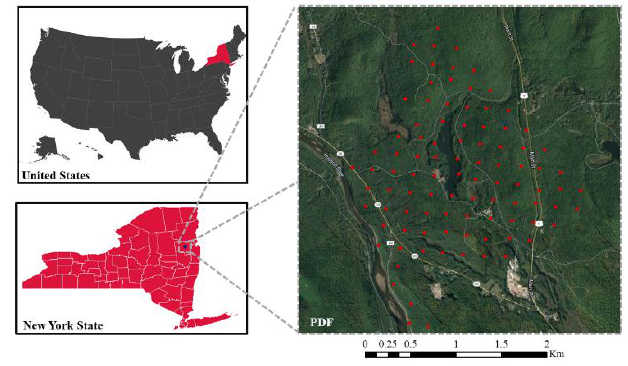
Figure 1 . Location of the study area (Warren, NY). Red circles indicate sample plots located in Pack demonstration forest